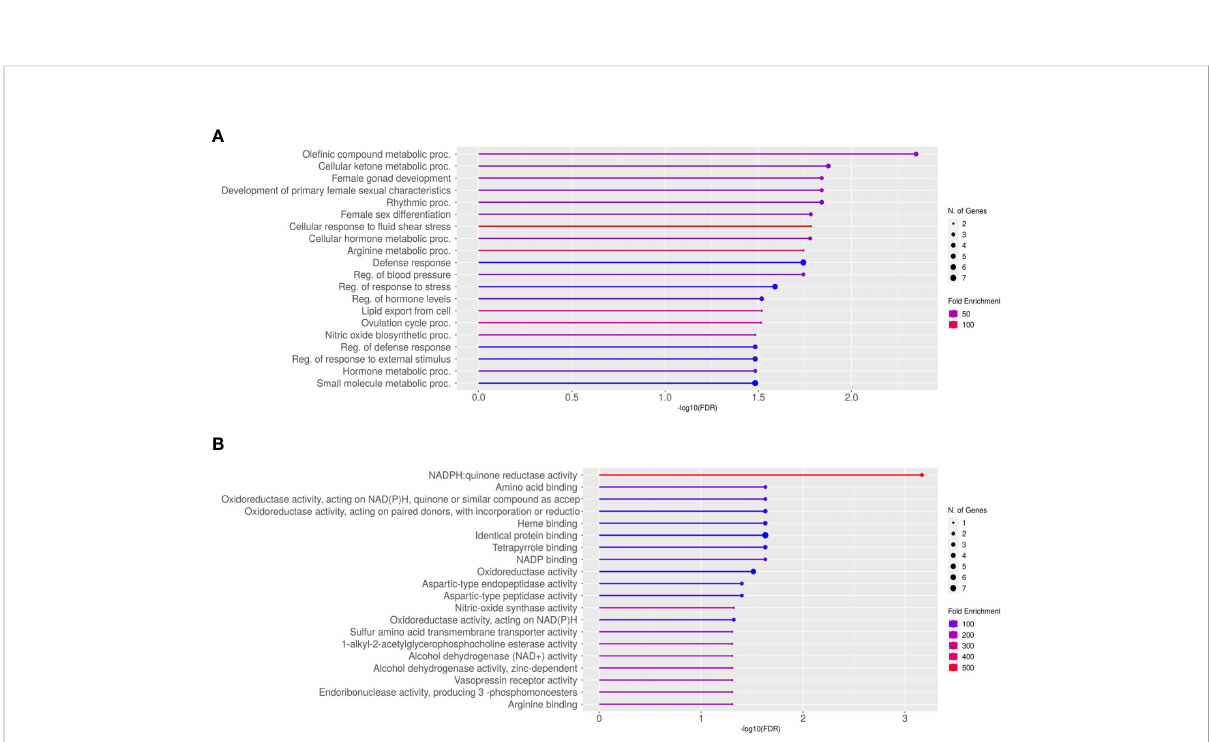
FIGURE 6 Lollipop Chart of gene ontology enrichment for the top 20 overrepresented pathways for (A) Biological Processes and (B) Molecular Function. FDR <